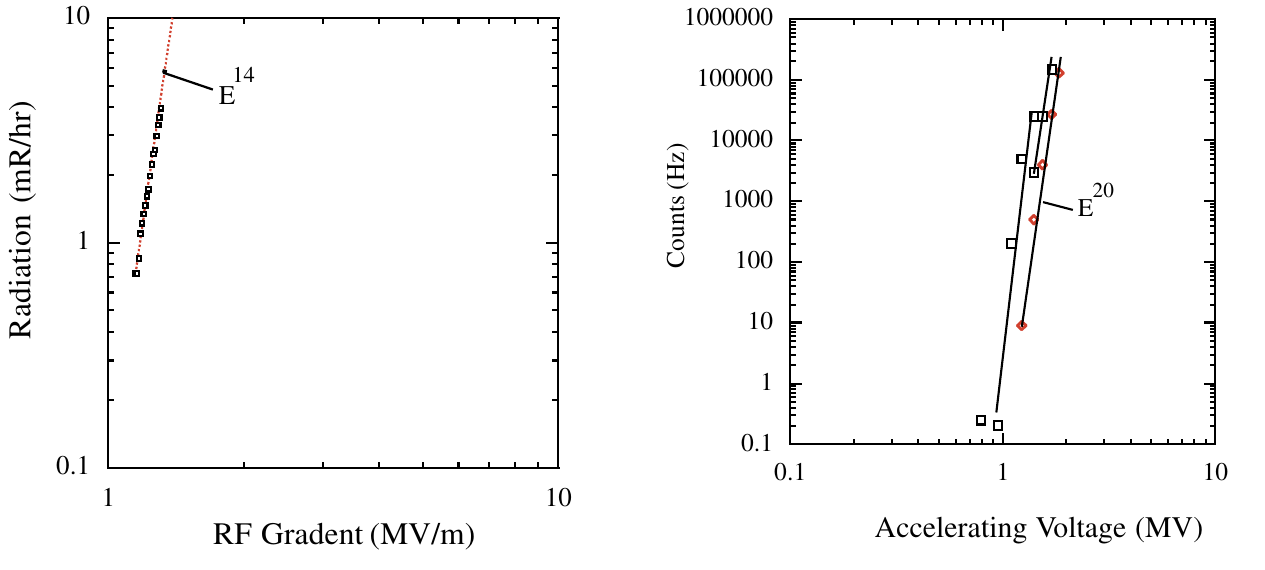
FIG. 29. (Color) Radiation fluxes near the proton linac of IPNS. FIG. 31. (Color) X-ray fluxes from an rf cavity operating in the CESR